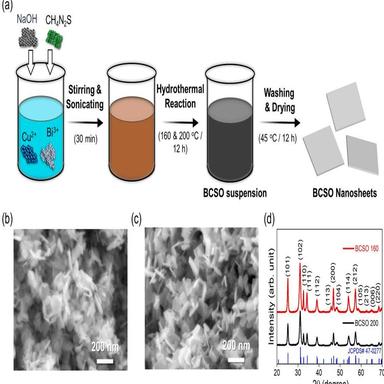
Synthesis and characterization of BCSO: (a) Schematic representation of hydrothermal synthesis of BCSO nanosheets, SEM image of BCSO prepared at (b) 160 ◦C & (c) 200 ◦C, and (d) XRD patterns.